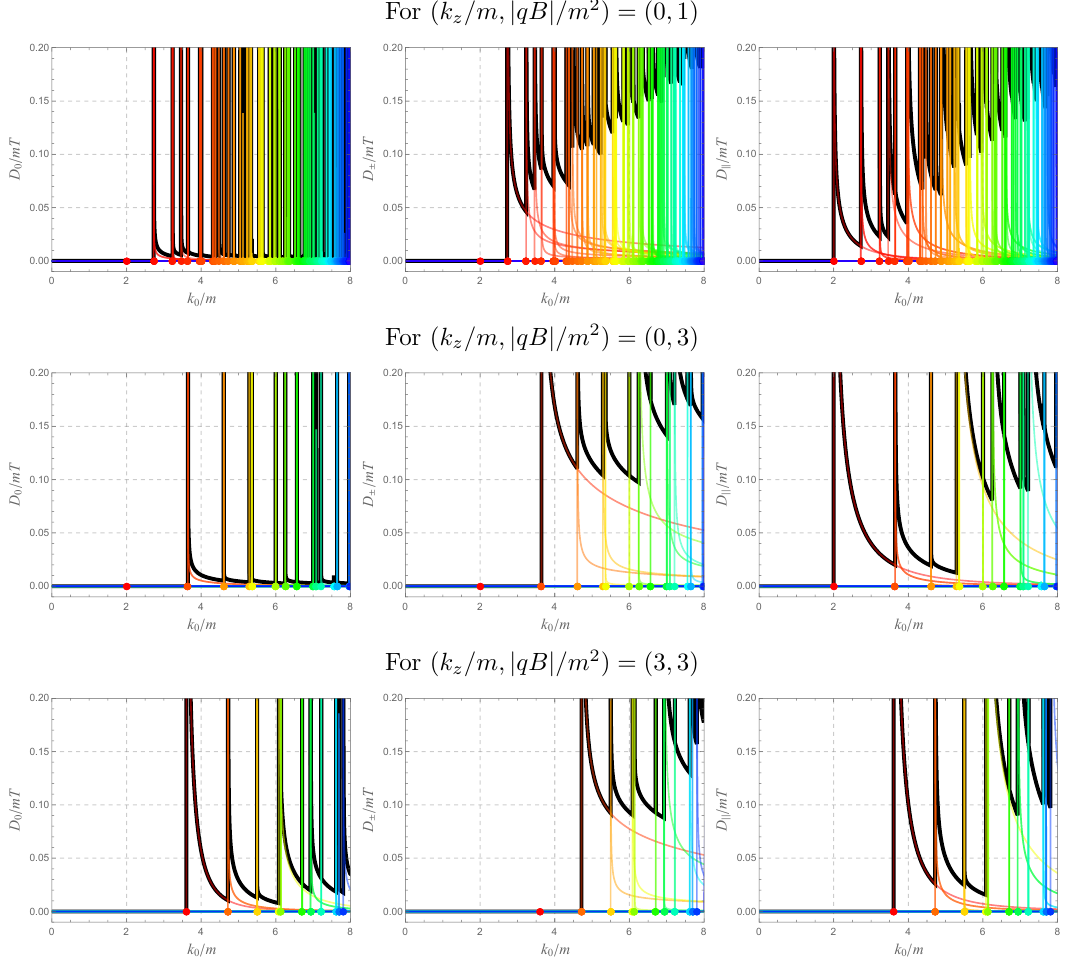
Figure 4 . Photon-energy dependences of the conversion rates: D 0 (left), D ± (middle), and D k (right). The photon transverse momentum is fixed at | k = 1 , and the other parameters are at ⊥ | /m ( k 2 ) = (0 , 1) [first row], (0 , 3) [second row], and (3 , 3) [third row]. The colored dots on z /m, | qB | /m the horizontal axes indicate the threshold energies (4.4) in ascending order from red, representing the lowest threshold for the lowest Landau level pair n = n 0 = 0 , to blue for higher Landau level pairs. The colored lines originating from each dot show the contributions from each Landau level pair D n,n 0 . The black lines show the total contribution summed over the Landau levels D λ λ